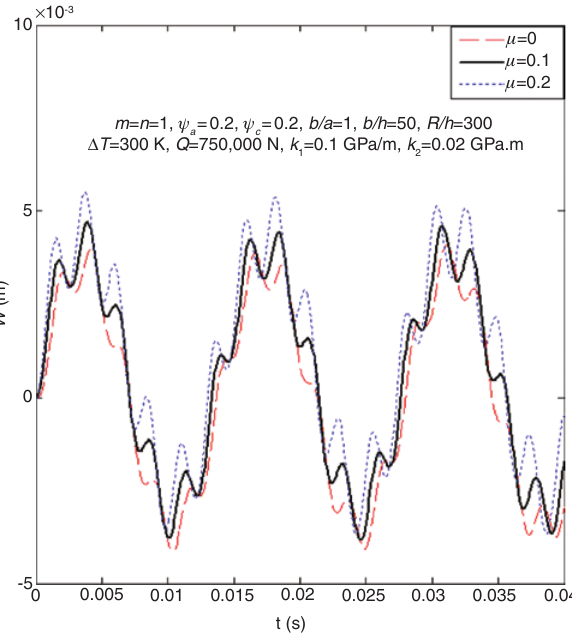
Figure 9: Effect of the imperfection parameter on the non-linear dynamic response of the polymer composite cylindrical